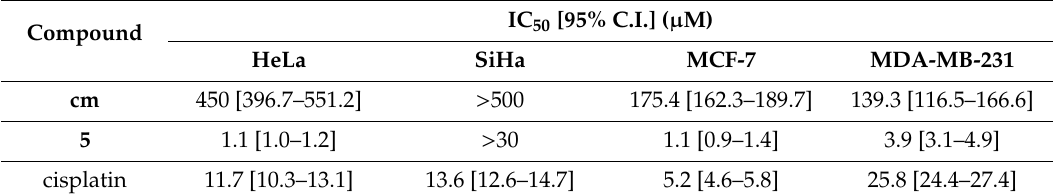
Table 1. Cytotoxic activity of compound 5 in comparison with its parent compound cm . Cisplatin was used as positive control; results were obtained from two biological replicates, 5 replicates each (n = 10); 95% C.I. refers to 95% confidence interval for the calculated IC 50